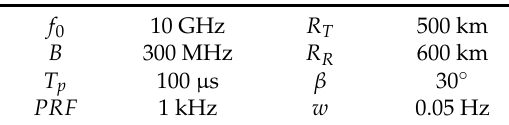
Figure 4. ( a ) Aircraft model, ( b ) RD-based image, and ( c ) 2D-SL0-based image. Table 1. Simulated